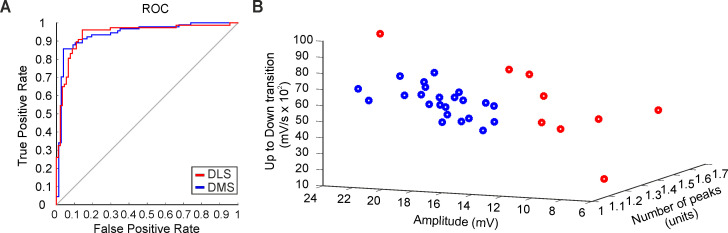
Classification of DLS- and DMS-MSNs at animal level.(A) One-animal-out classification, ROC curve of the DLS/DMS. (B) Subspace of classification based on the RFE results. Each dot represents the average of all neurons recorded in single mouse, in DLS (red) or DMS (blue).